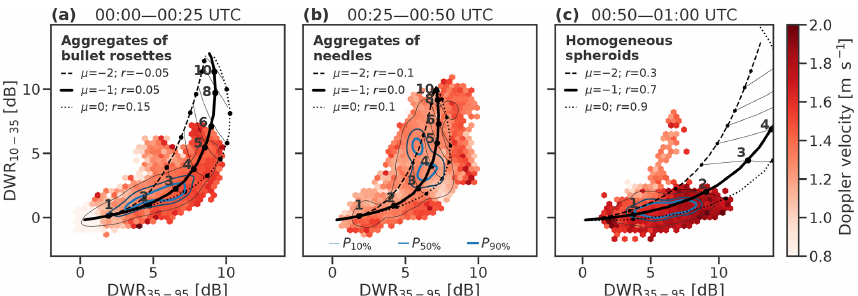
Figure 12. Triple-frequency radar measurements from below 1km above ground level during the 16 February case. The data are divided into three regimes and overlaid by a range of particle models, as informed by PIP measurements. Throughout this case a PSD shape parameter of µ = − 1 was measured in situ. (a) The period 00:00–00:25UTC is consistent with the triple-frequency radar signature of aggregates of bullet rosettes (Table 1), (b) the period 00:25–00:50UTC is consistent with aggregates of needles (Table 1) and (c) the period 00:50–01:00UTC is consistent with homogeneous spheroids. The triple-frequency radar measurements are coloured by the average mean Doppler velocity and blue contours mark the 10th, 50th and 90th percentiles of the frequency of the